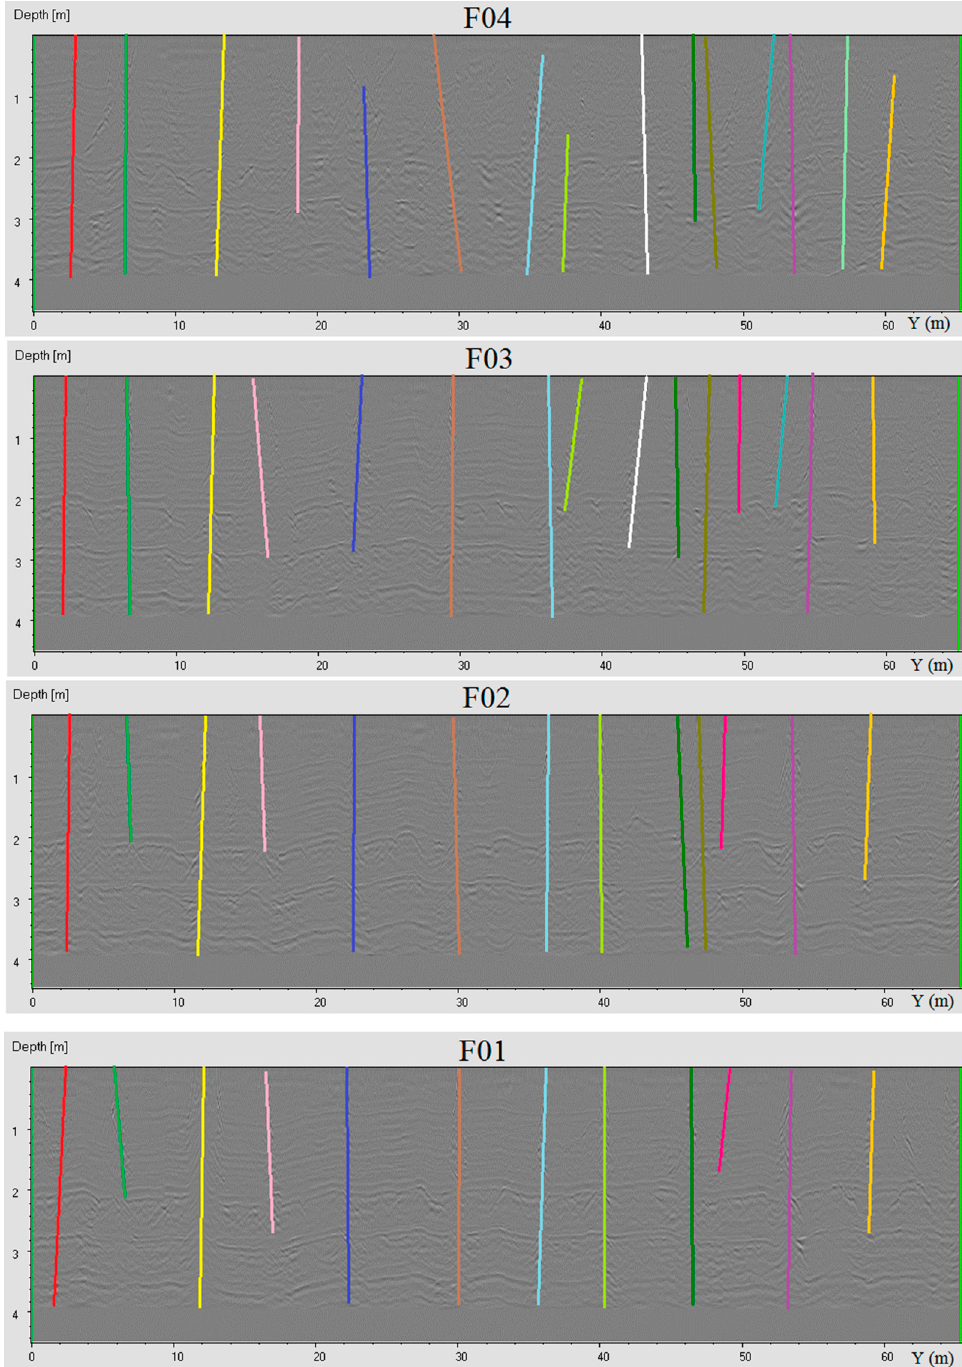
Figure A1. Volume 1: The interpreted radargrams F01, F02, F03, and F04.